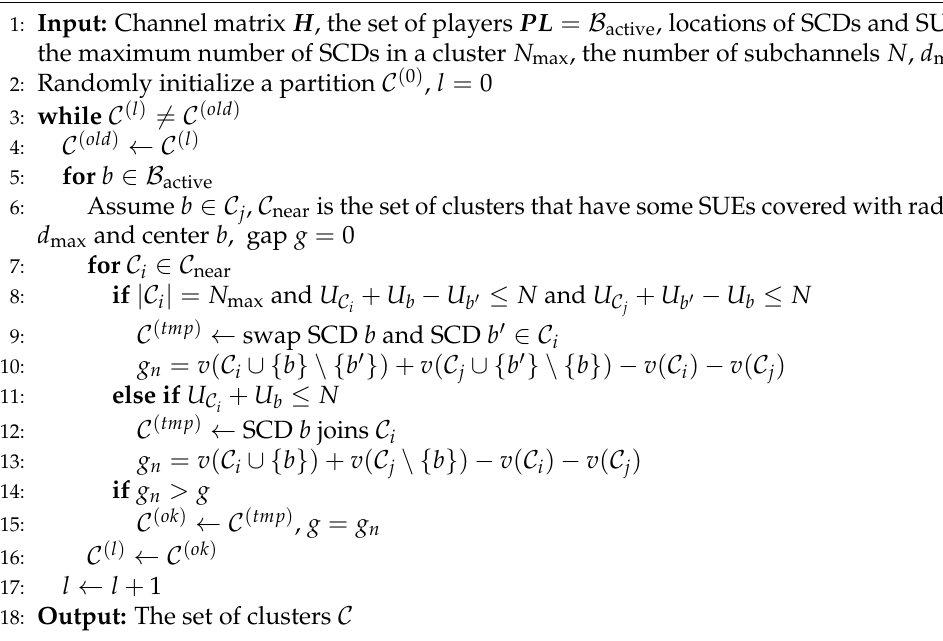
Algorithm 1 Clustering SCDs using the coalition